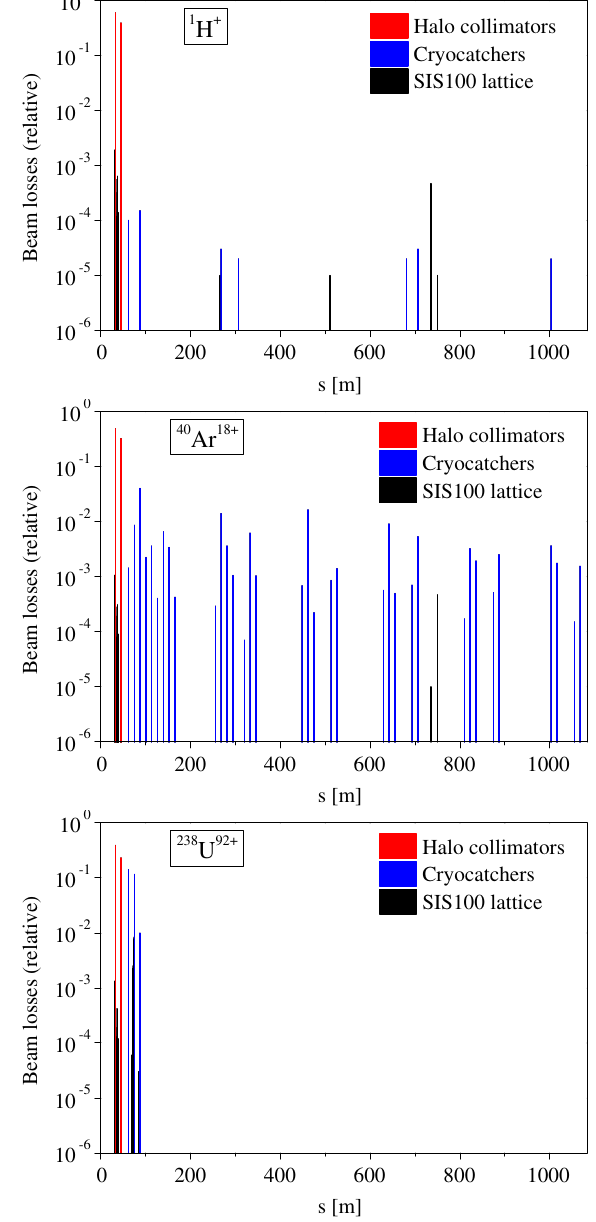
FIG. 6. Distribution of the lost beam particles along the SIS100 lattice for 1 H þ , 40 Ar 18 þ , and 238 U 92 þ beams. The ion-foil interaction and the particle tracking were simulated by using FLUKA and MAD – X ,